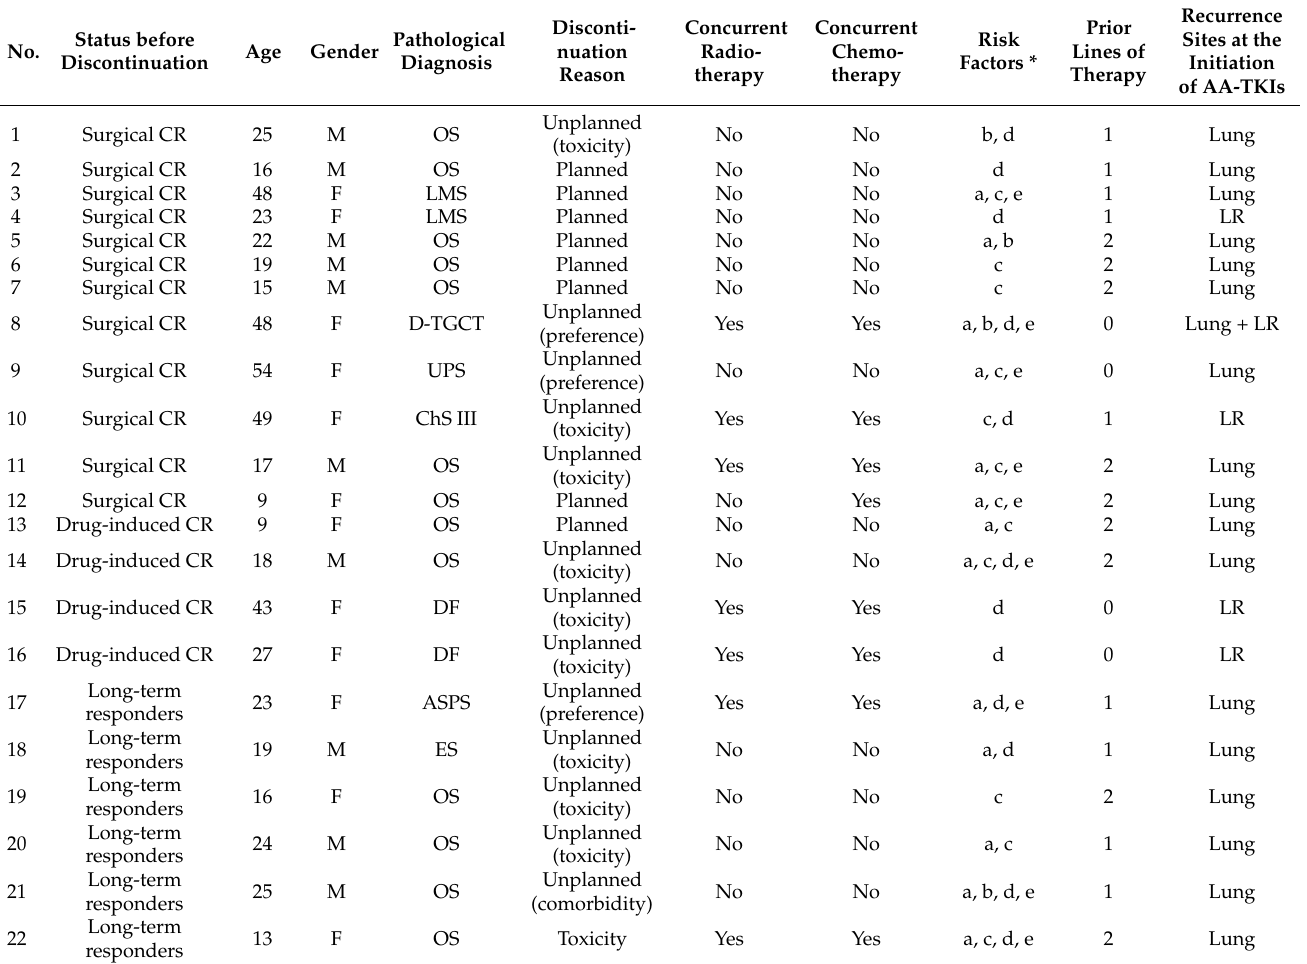
Table 1. Clinical characteristics of 22 patients before the AA-TKI